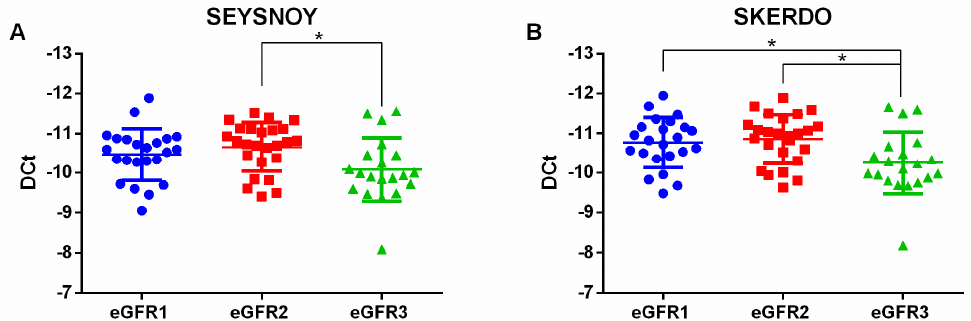
Figure 4. Dot plots of seysnoy ( A ) and skerdo ( B ) transcripts validated through qPCR in serum samples of diabetic patients with increasing eGFR stages G1, G2 and G3. The one-way ANOVA test was used for the two transcripts showing parametric distributions. n = 69: G1 = 24, G2 = 25, G3 = 20. * p -value < 0.05.